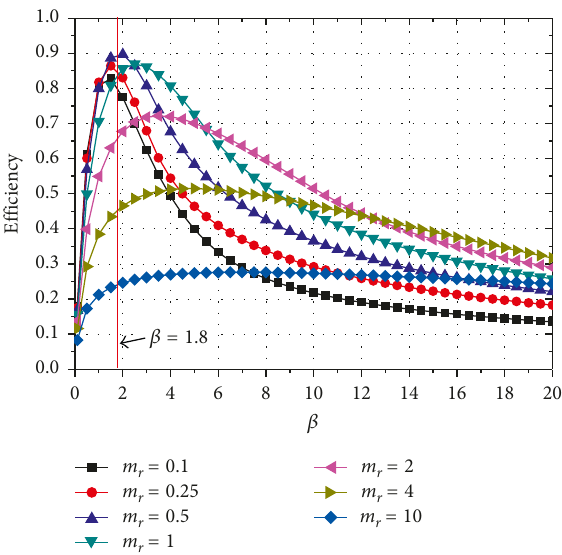
Figure 7: Dimensionless time capable of reaching U m for an in- cident stress-wave τ acting on the bit and β . Figure 8: Drilling efficiency of percussive drilling systems with respect to β and m r